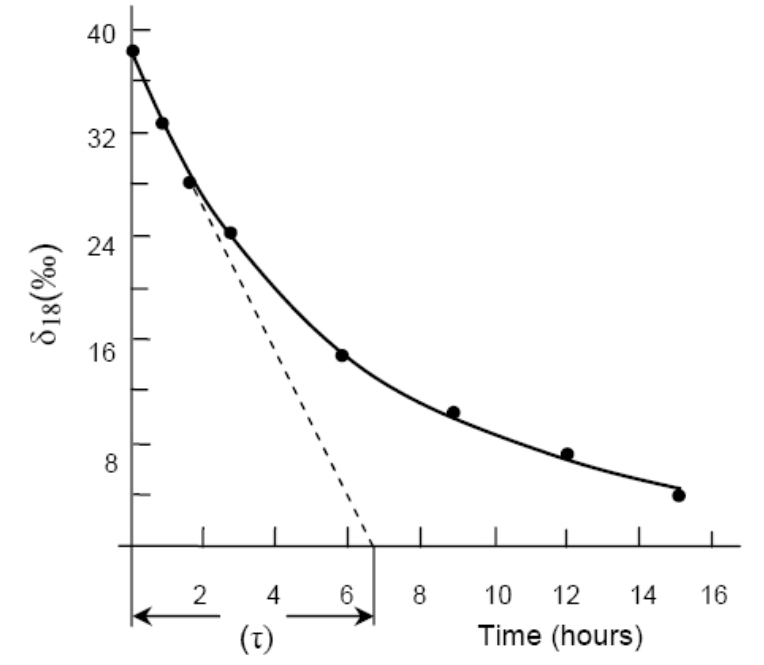
Fig. 2 Water exchange through a membrane. Change of δ over time. Installation-fig. 1, membrane − 30 μ thickness, ambient temperature, initial δ value in the enriched cell is +38 . 4 (cid:2) , the normal water flow through the neighboring 18 cell, δ in the enriched cell relates to normal 18